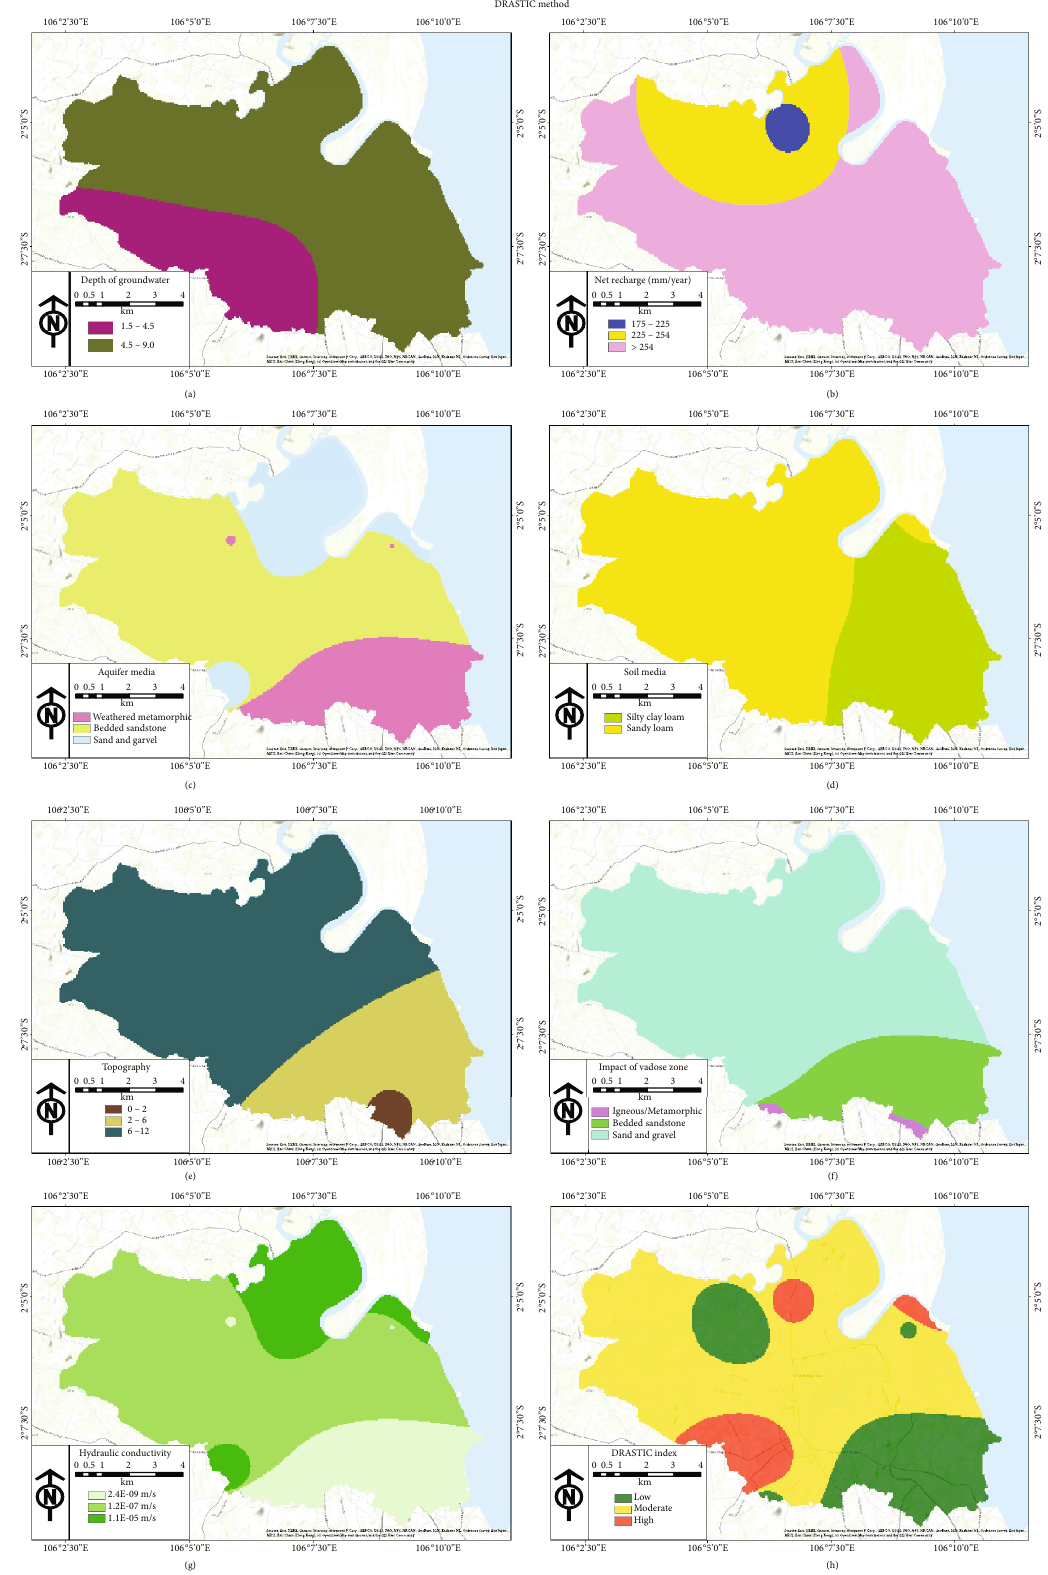
Figure 11: DRASTIC method: (a) depth of groundwater; (b) net recharge; (c) aquifer media; (d) soil media; (e) topography; (f) impact of vadose zone; (g) hydraulic conductivity; (h) DRASTIC